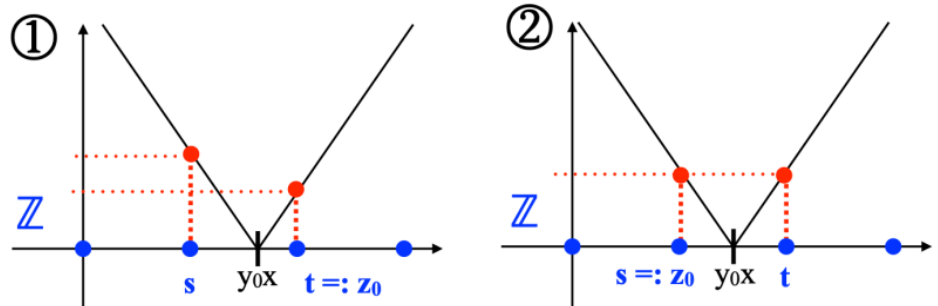
𝑥 . Figure 13. The potential positions of y 0 0 x